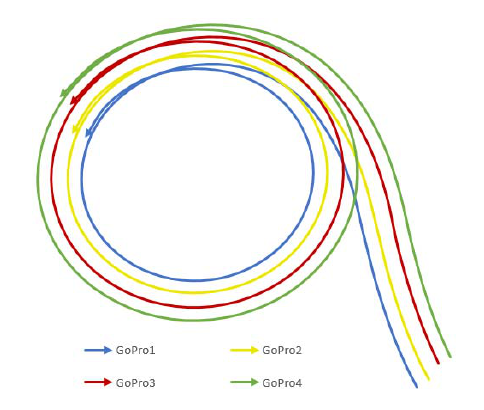
Fig. 6: Trajectories of cameras in a traffic circle Image sequences were conventionally processed with the Photoscan software: